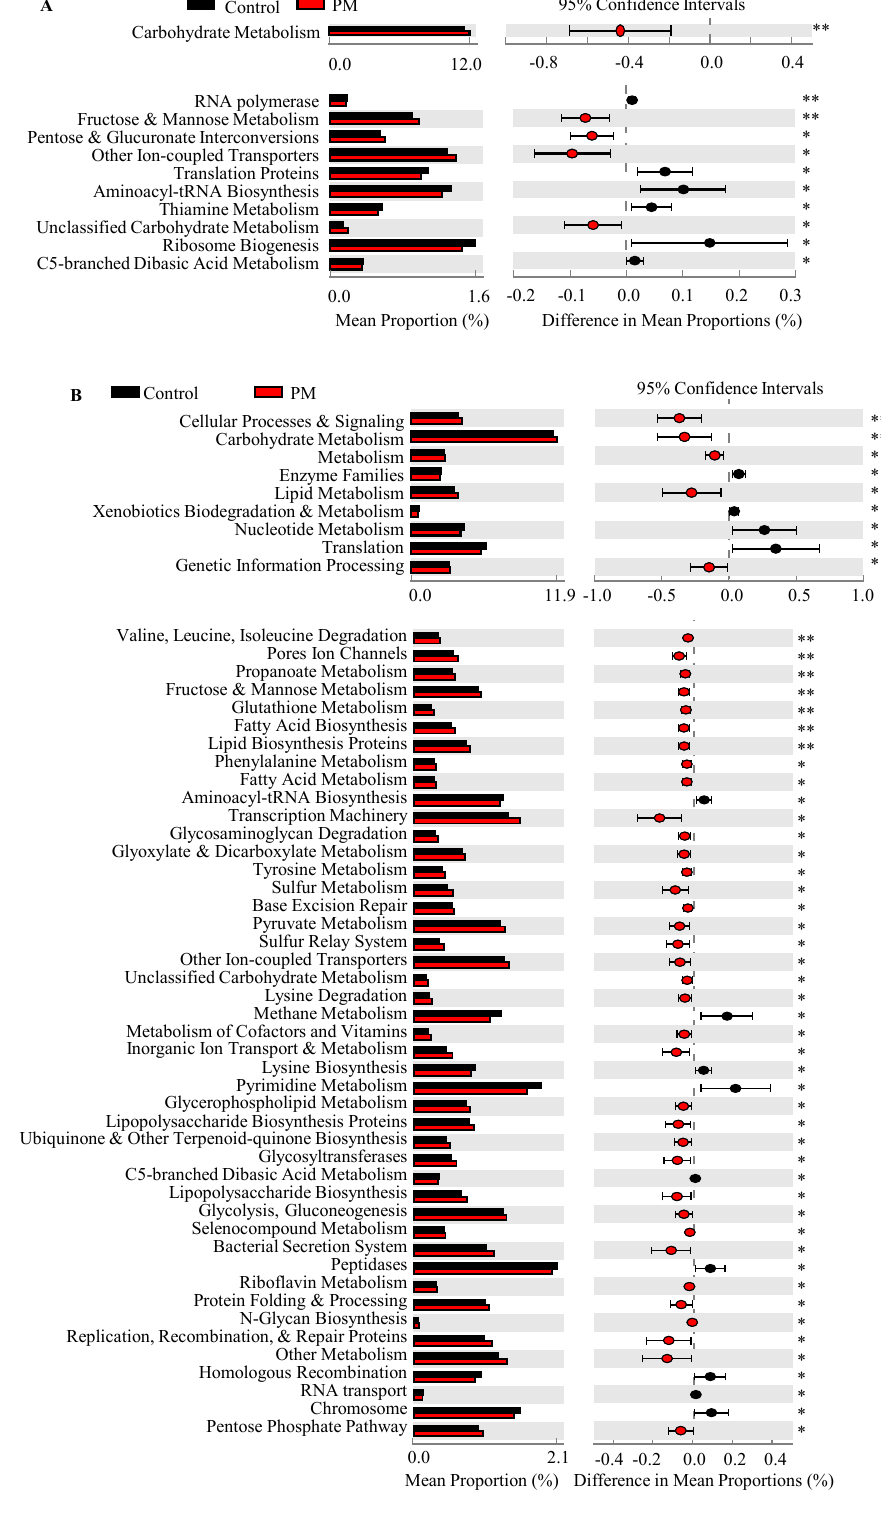
Figure 3. Predictive functional analysis of fecal microbiota in control and PM-treated mice. Predictive functional analysis of OTU data described in Figures 1 and 2 was performed using PICRUSt and analyzed and visualized in STAMP showing designated functions at the 2nd ( A ) and 3rd ( B ) level of functional hierarchy at day 30 (upper panels) and 45 (lower panels) between control and PM-treated mice. FDR corrected p -values (Welch’s t -test) are shown. * p < 0.05 and ** p <